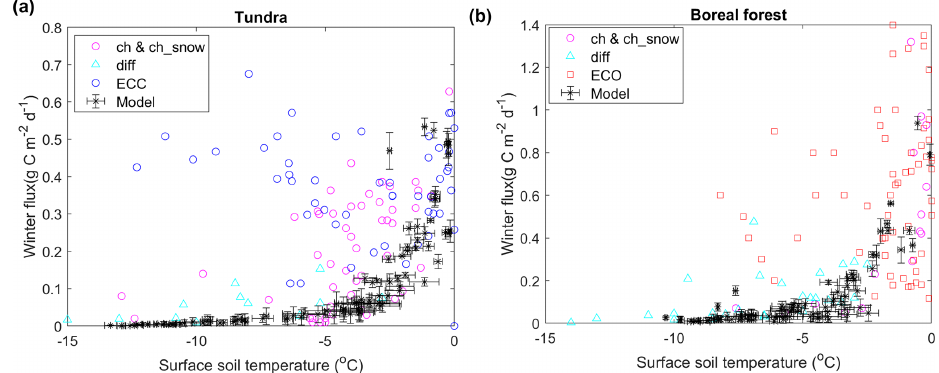
Figure 6. Effects of soil temperature on CO 2 fluxes during the cold season over Alaskan tundra (a) and boreal forest (b) sites indicated by model simulations (this study) and in situ observations from a winter flux synthesis data set (Natali et al., 2019b). The terms “ch&ch_snow”, “diff”, “ECC”, and “ECO” represent measurements made using chambers and chambers placed atop the snowpack, diffusion, EC-closed path, and EC-open path methods, respectively. The error bars indicate the standard deviations of model simulations using different values (0.35–0.9) for the dimensionless parameter characterizing the unfrozen water curve for most soil types (Schaefer and Jafarov,